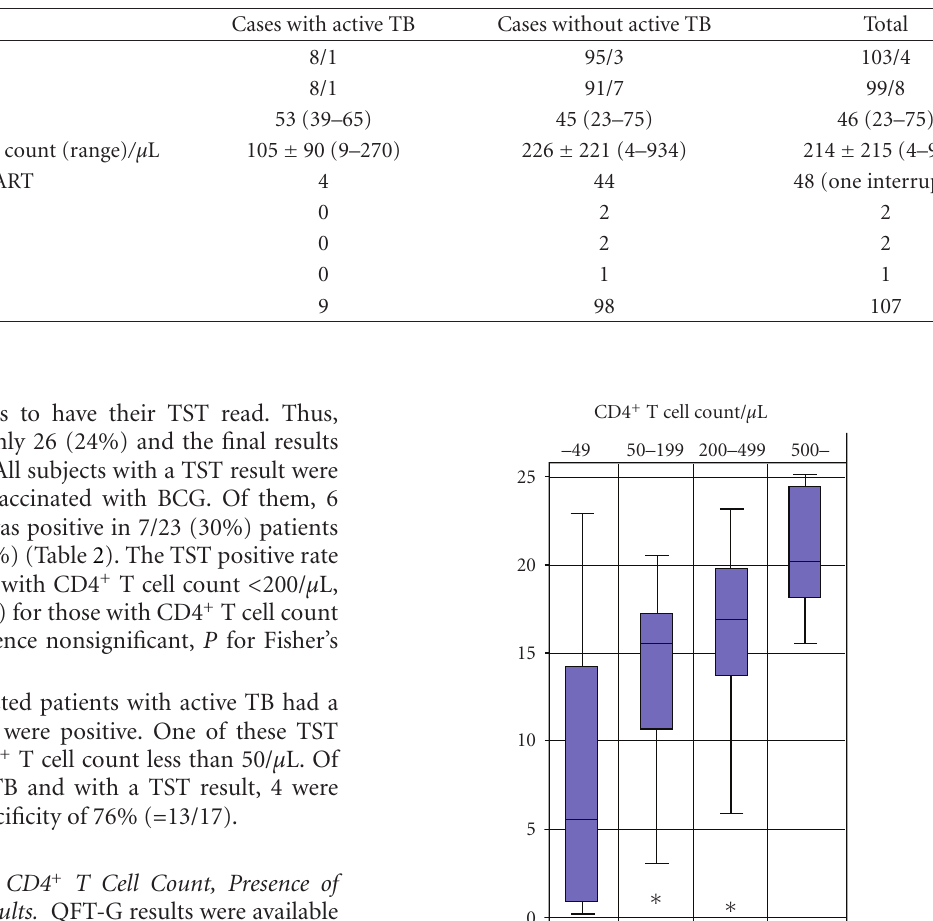
Table 1: Characteristics of subjects.